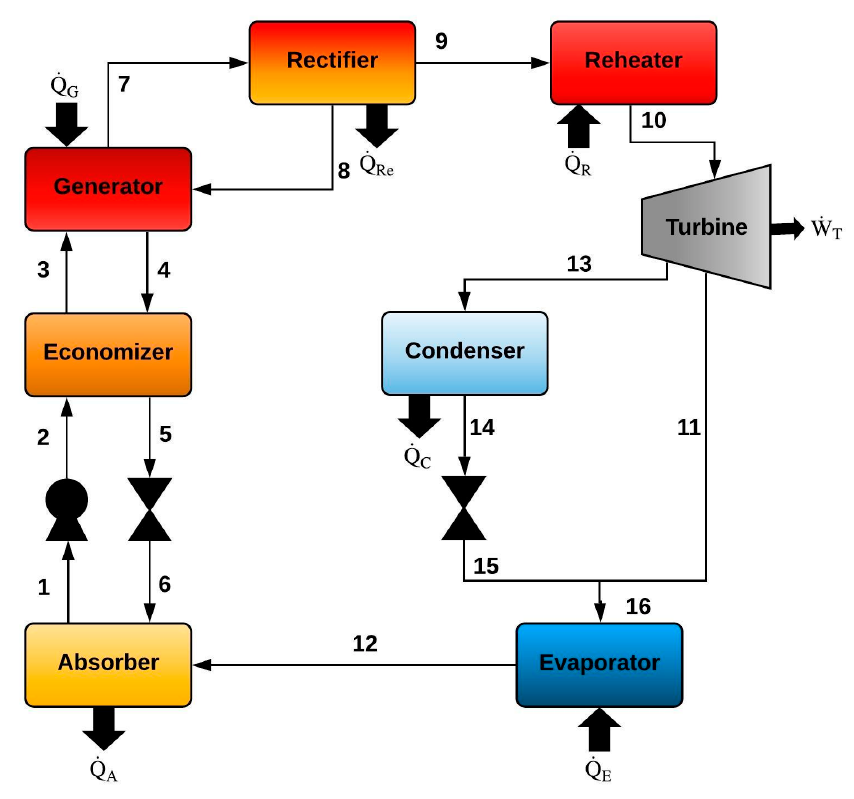
Figure 3. Goswami cycle with a condenser and a flow division into the turbine.